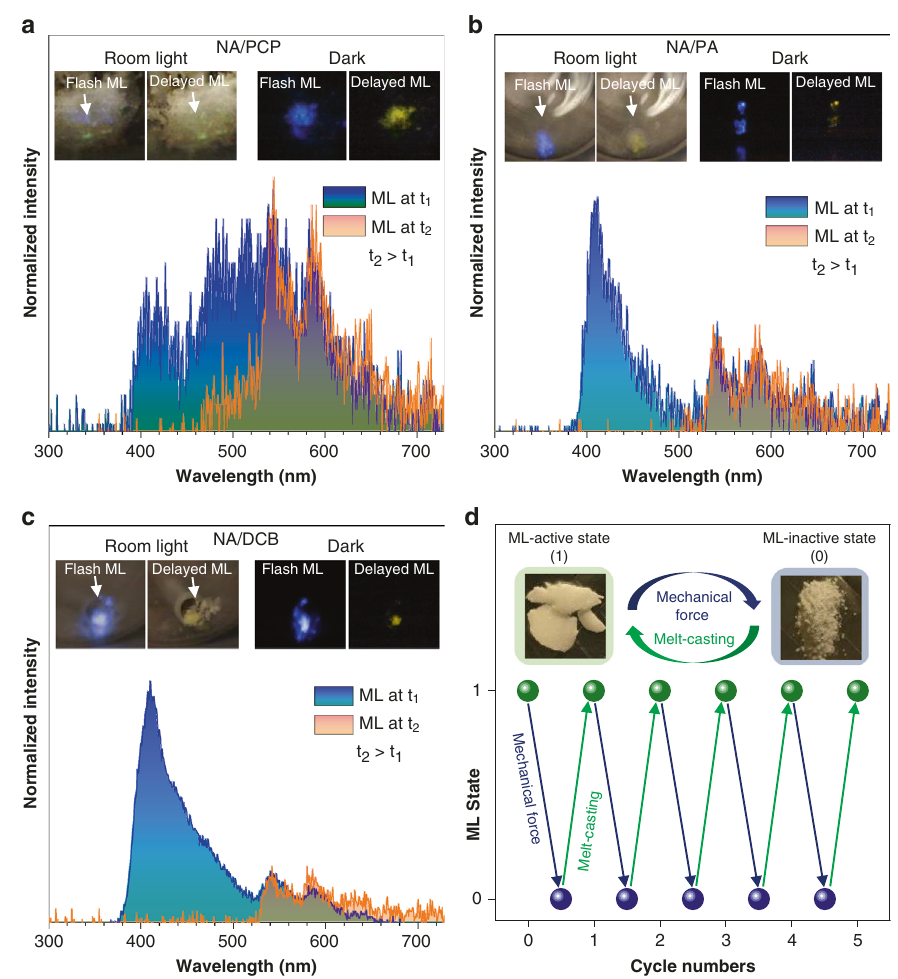
Fig. 4 Mechanoluminescence (ML) properties of the guest/host system. a ML spectra of NA/PCP at different delay times (t 1 and t 2 , t 2 > t 1 ). Insert (left): photos showing the fl ash-like ML of NA/PCP upon crushing the sample on the wall of a glass vial under soft room light and delayed ML after the crushing ceased. Insert (right): photos showing the fl ash-like and delayed ML of NA/PCP in the dark. b , c are the same as ( a ) except that NA/PA and NA/DCB were used, respectively, instead of NA/PCP. d Plot of ML state (1-on, 0-off) versus repeated mechanical force and melt-casting treating. Insert: photos showing the appearance of NA/PA after melt-casting (left) and crushing (right) and the repeated treating